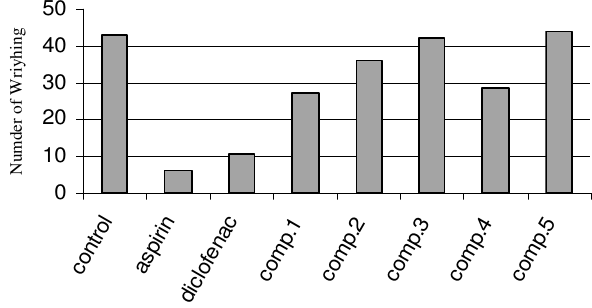
Figure 8 . Writhing tests of histidine derivatives